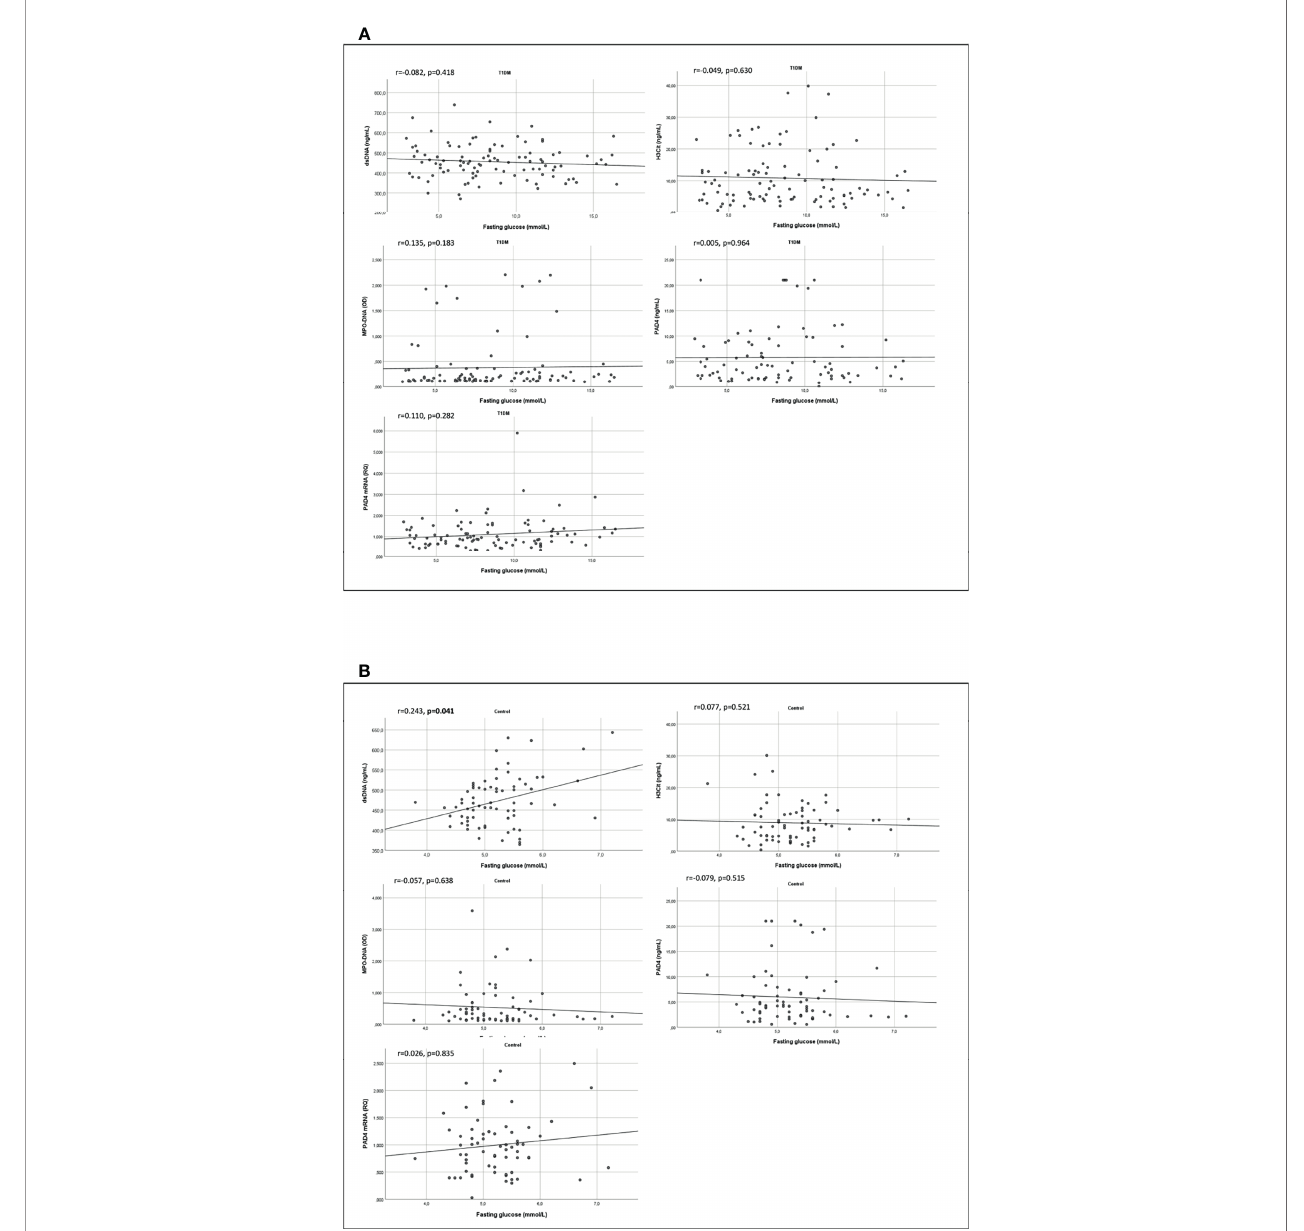
FIGURE 3 | Correlations between NETs markers and fasting glucose in T1DM and controls. Scatter graphs with trend line showing correlations between markers of NETs and fasting glucose in TIDM (A) and in controls (B) . T1DM, type 1 diabetes mellitus; dsDNA, double-stranded deoxyribonucleic acid; MPO-DNA, myeloperoxidase-DNA; H3Cit, citrullinated histone 3; PAD4, peptidylarginine deiminase